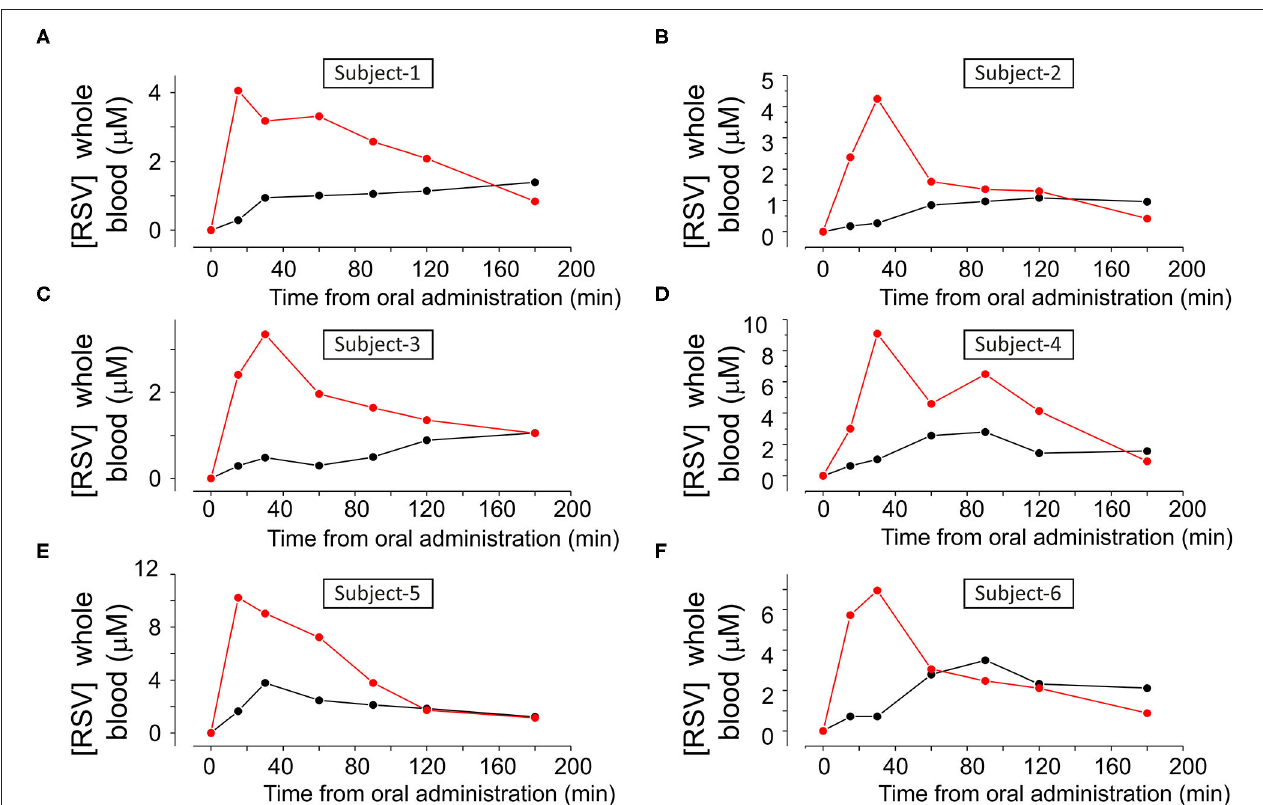
FIGURE 4 | (A–F) Concentration of resveratrol in whole blood as a function of the time, in each subject after treatment with either (A) 180mg pure Resveratrol (Polygonum cuspidatum 98%, (black dots) or (B) 180mg Resveratrol from Resv@MDH after oral administration (red dots).